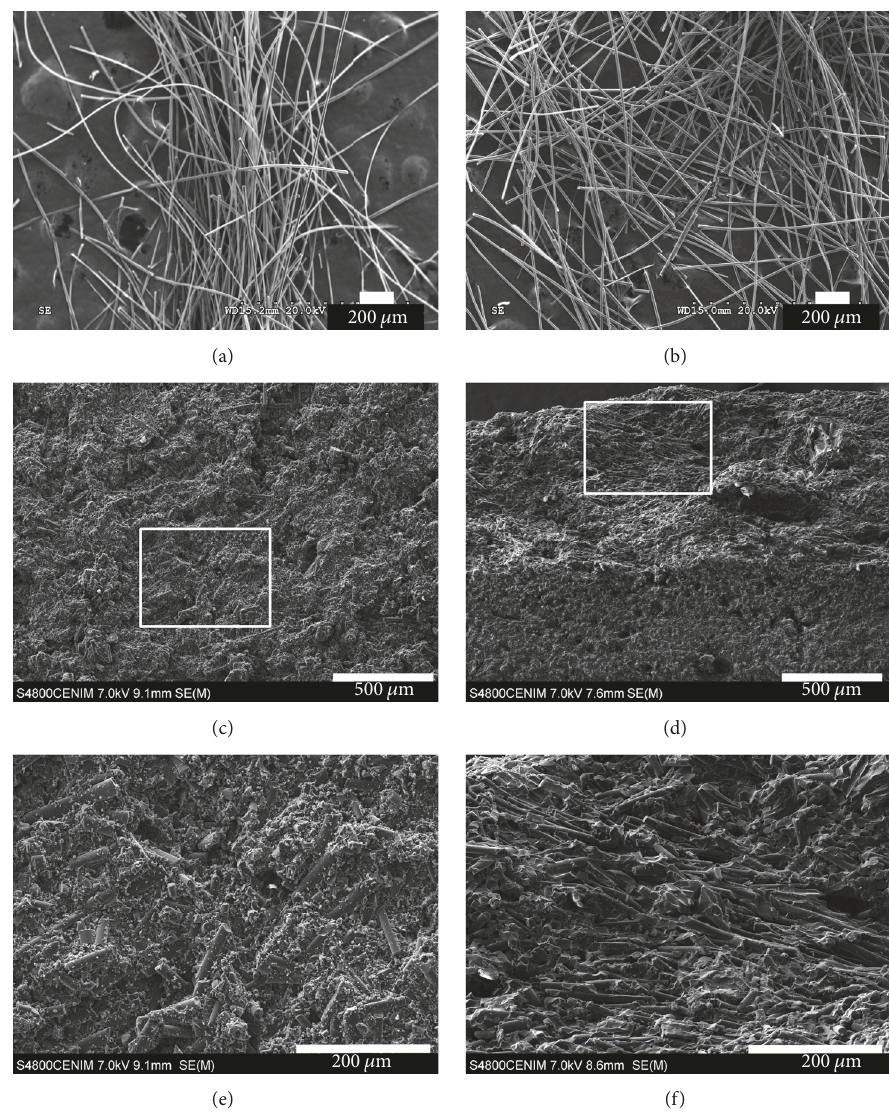
Figure 2: SEM images of the pristine activated carbon fibers (a) ACF15 and (b) ACF25; low resolution SEM images of the ACF monoliths (c) ACF15-M and (d) ACF25-M, the white squares indicating the enlarged areas shown in high resolution SEM images of (e) ACF15-M and (f) ACF25-M,